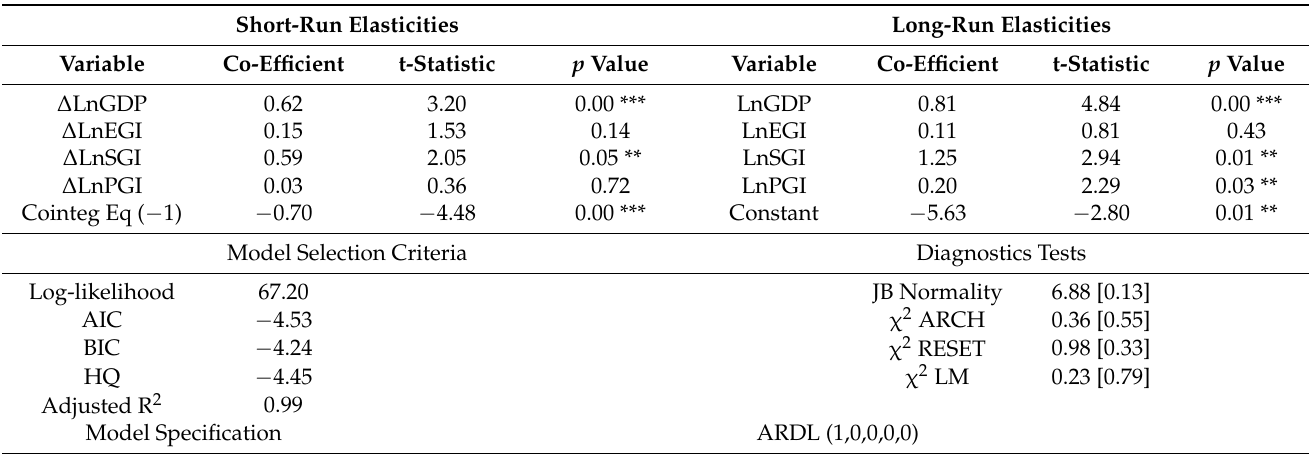
Table 5. Results of symmetric ARDL.